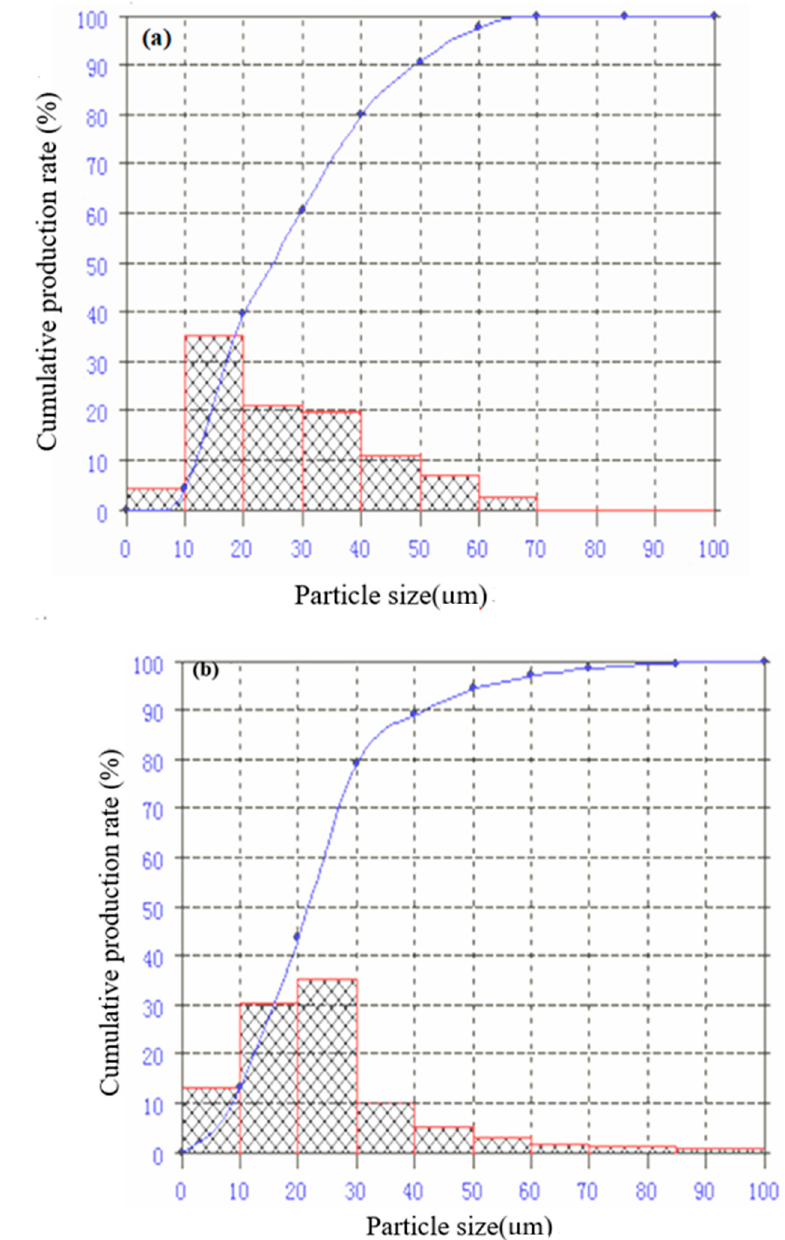
Figure 3. Particle size distribution of ( a ) CFA and ( b ) CFAMH.